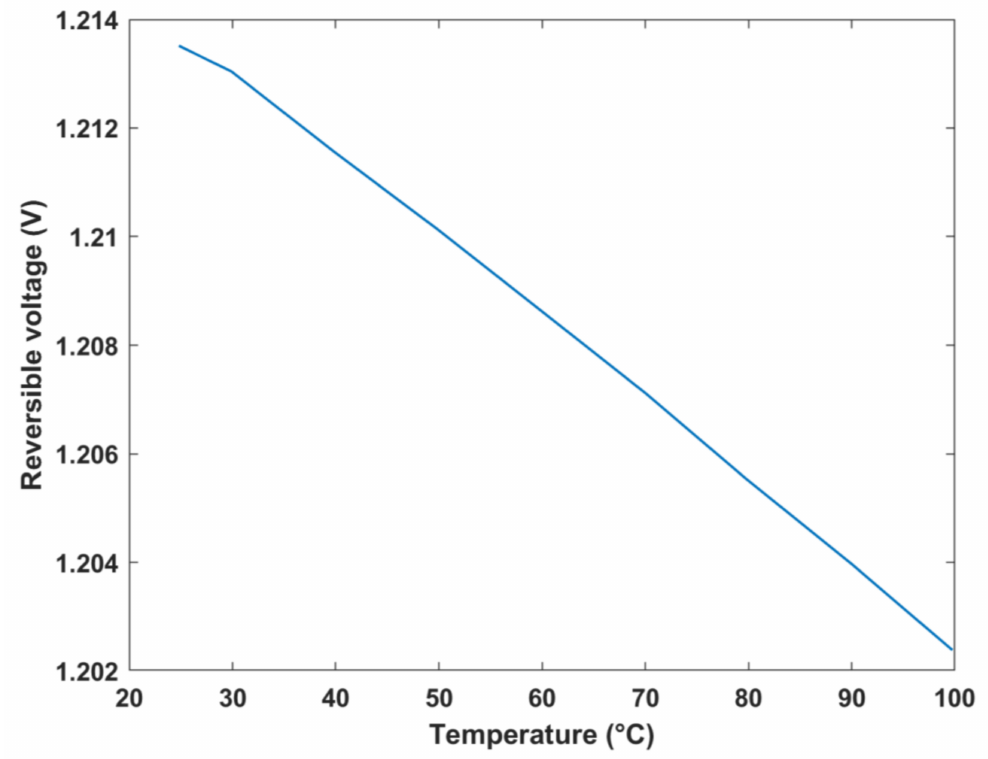
Figure 9. Reversible voltage vs.